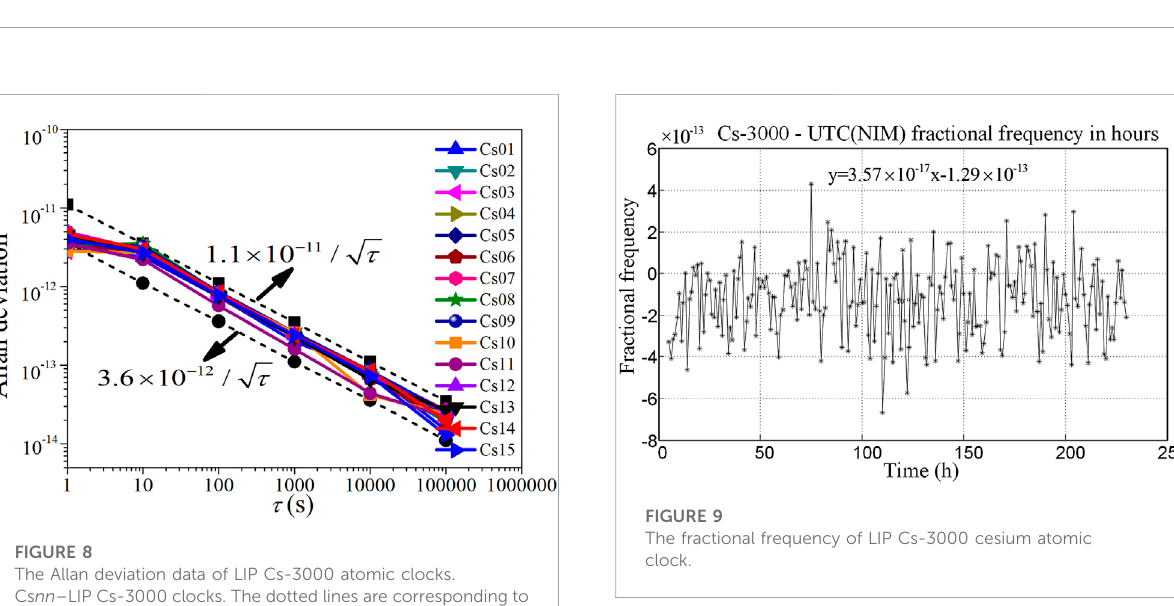
FIGURE 7 The signal-to-noise ratios of the CBTs. (A) Statistical chart of the signal-to-noise ratios of CBTs from 2018 to 2021. (B) Burr type XII distribution fi tting for the signal-to-noise ratio of all tubes.